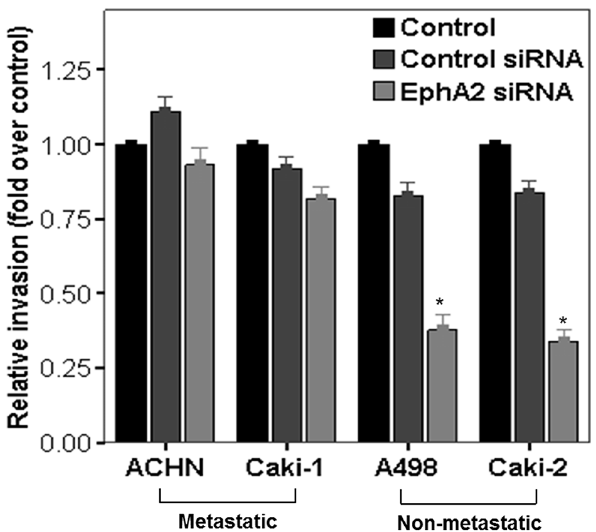
Fig 5. Effect of EphA2 siRNA on cellular invasiveness in human RCC cell lines. Cellular invasiveness was compared among untreated cells (control), control siRNA treated cells and EphA2 siRNA treated cells at 48 hours following treatment in metastatic RCC cell lines (ACHN and Caki-1) and non-metastatic RCC cell lines (A498 and Caki-2) Bar graph compared cellular invasiveness among the three groups using densitometry. The results were presented as fold changes over controls. * p < 0.05 vs. control and control siRNA treated groups. siRNA = small interfering RNA, RCC = renal cell